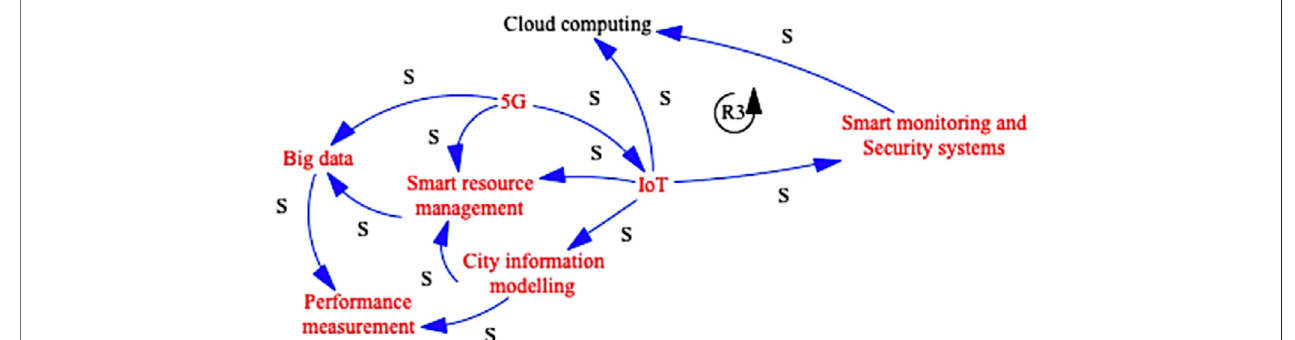
FIGURE 7 | System archetype 2- Internet of things and data management. Source: Authors.